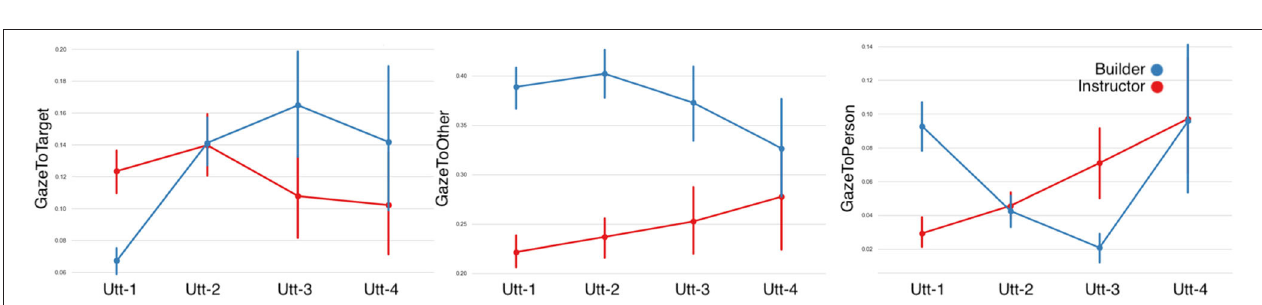
FIGURE 10 | Eye-gaze features per utterance sequence. (A) GazeToTarget referent, (B) GazeToOther referents, and (C) GazeToPerson. Error bars indicate standard error of the means.